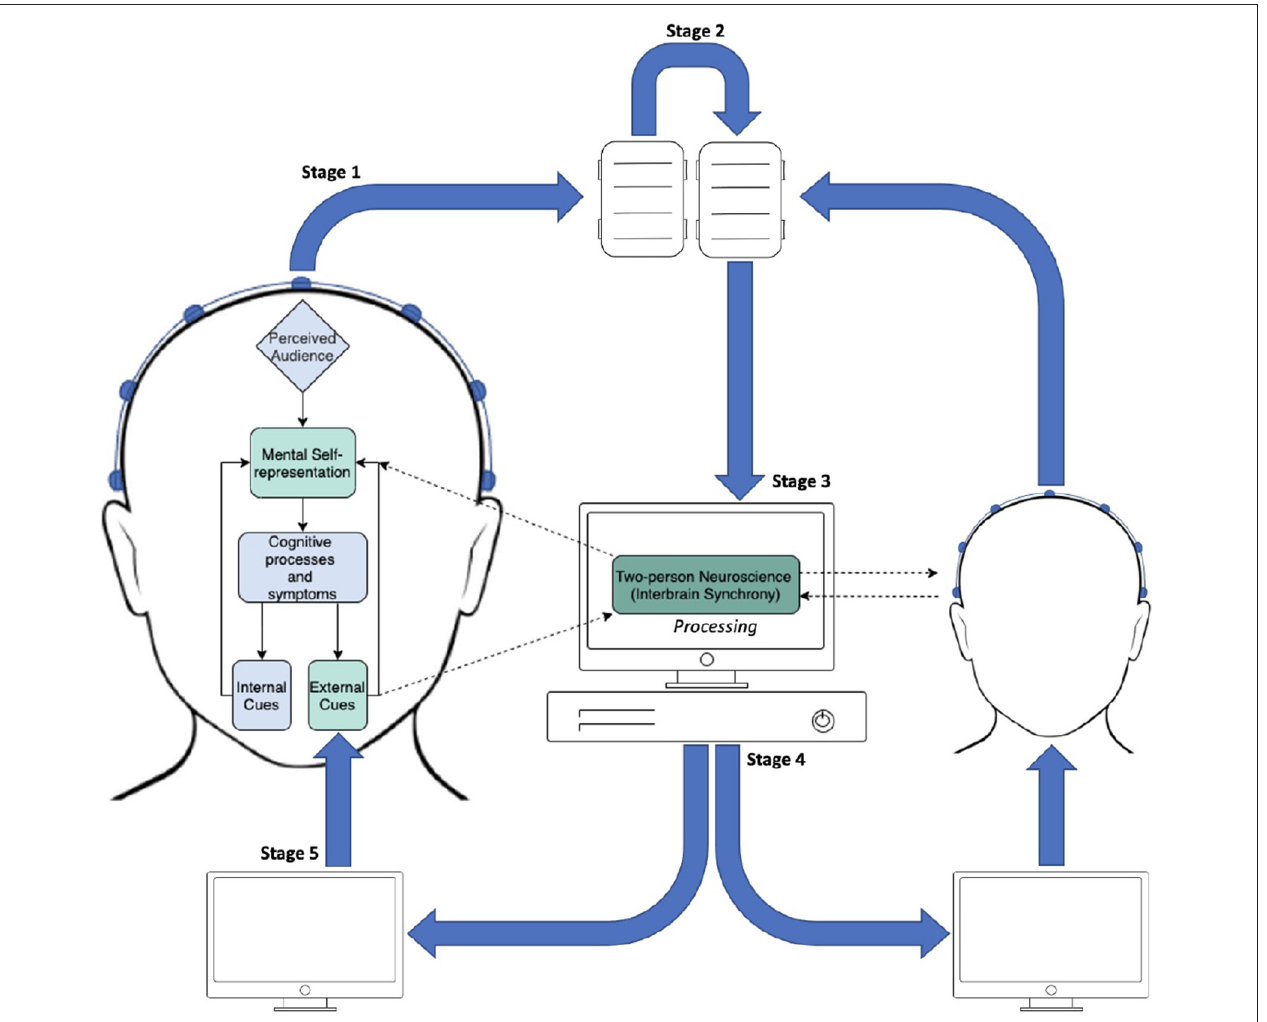
FIGURE 1 | Diagram of the proposed InBS-NF framework. Stage 1: EEG signals being sent from electrodes to amplifiers in two participants separately. Stage 2: daisy-chain link between amplifiers which are connected with different individuals. Stage 3: appended EEG signals from both participants being sent to the processing PC. The text “Processing” refers to a computational framework to calculate the measured degree of phase similarity for InBS. Stage 4: InBS values being sent to interactive simulation (separately for each participant) that represents the InBS values. Stage 5: participants observing InBS values as an external